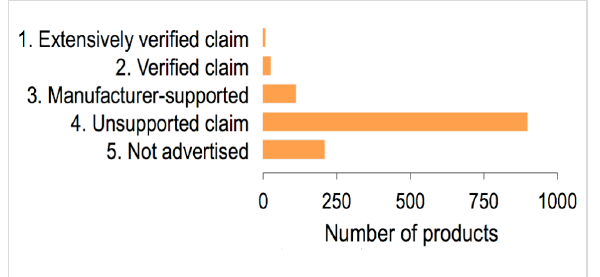
Figure 8: Distribution of products into the “How much we know” cate-